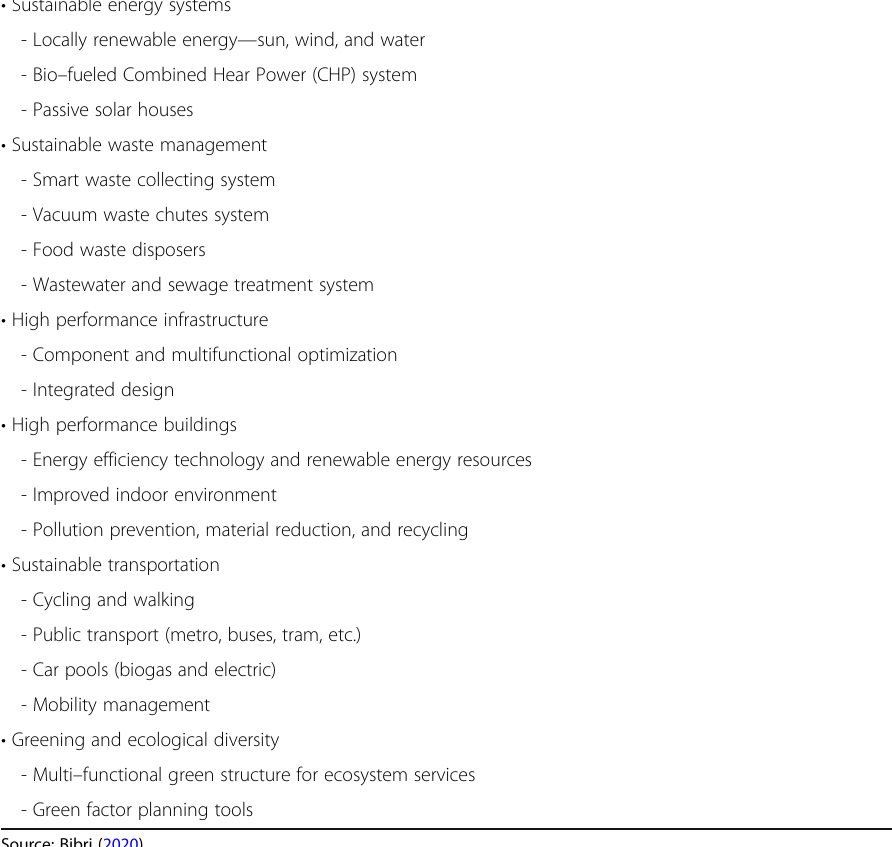
Table 1 Key strategies and solutions of the